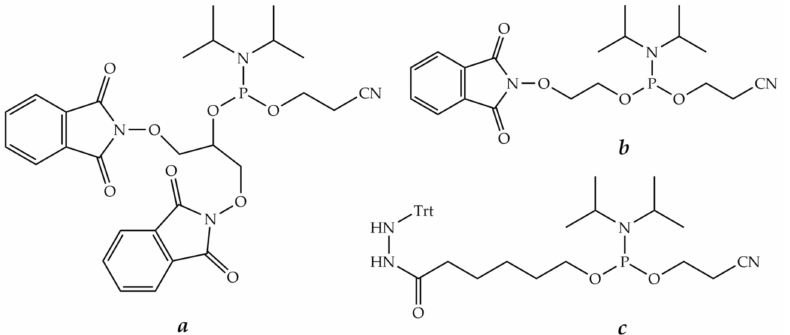
Figure 15. Phosphoramidite reagents for the introduction of aminooxy ( a , b ) and hydrazide ( c ) groups into oligonucleotides. Trt—triphenylmethyl (trityl)